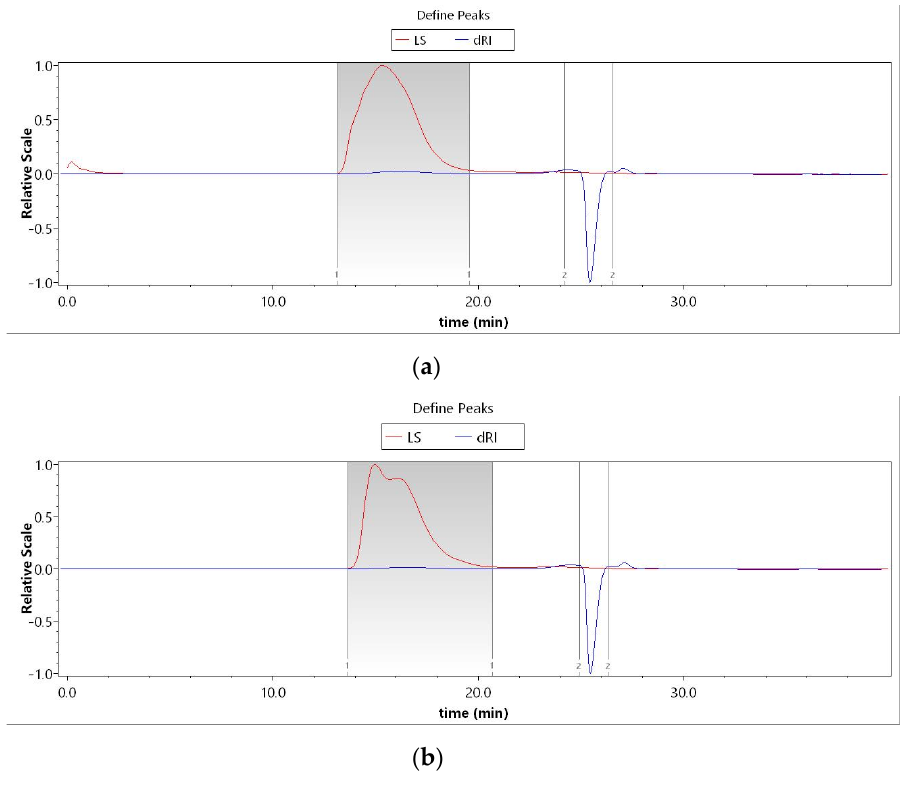
Figure 2. UF and LCF polysaccharide molecular weight analysis using GPC: ( a ) GPC analysis of UF; ( b ) GPC analysis of LCF. UF: unfermentation; LCF: single microbial fermentation with L. curvatus. Table 3. Distribution of molecular weights of polysaccharides in UF and LCF.